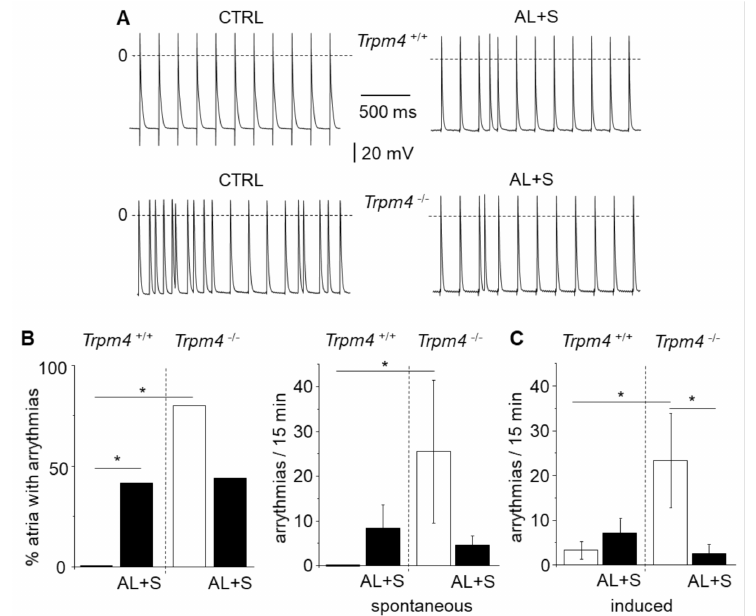
Figure 3. Occurrence of triggered arrhythmias on isolated left atria. ( A ) Representative recordings with action potentials from isolated left atrium recorded using intracellular microelectrodes for Trpm4 +/+ and Trpm4 -/- animals stimulated at 5 Hz. Triggered arrhythmias (early after depolarization and delayed after depolarization) were recorded in both groups after aldosterone + salt treatment but only on Trpm4 -/- animals without aldosterone + salt. ( B ) Percent of isolated left atria with arrhythmias (left) for both groups ( N = 9 to 12 as indicated in the text) and mean number of arrhythmias (right) during 15 min. ( C ) Mean number of arrhythmias induced by rapid pacing (10 s at 20 Hz). Statistical significance between groups are indicated by